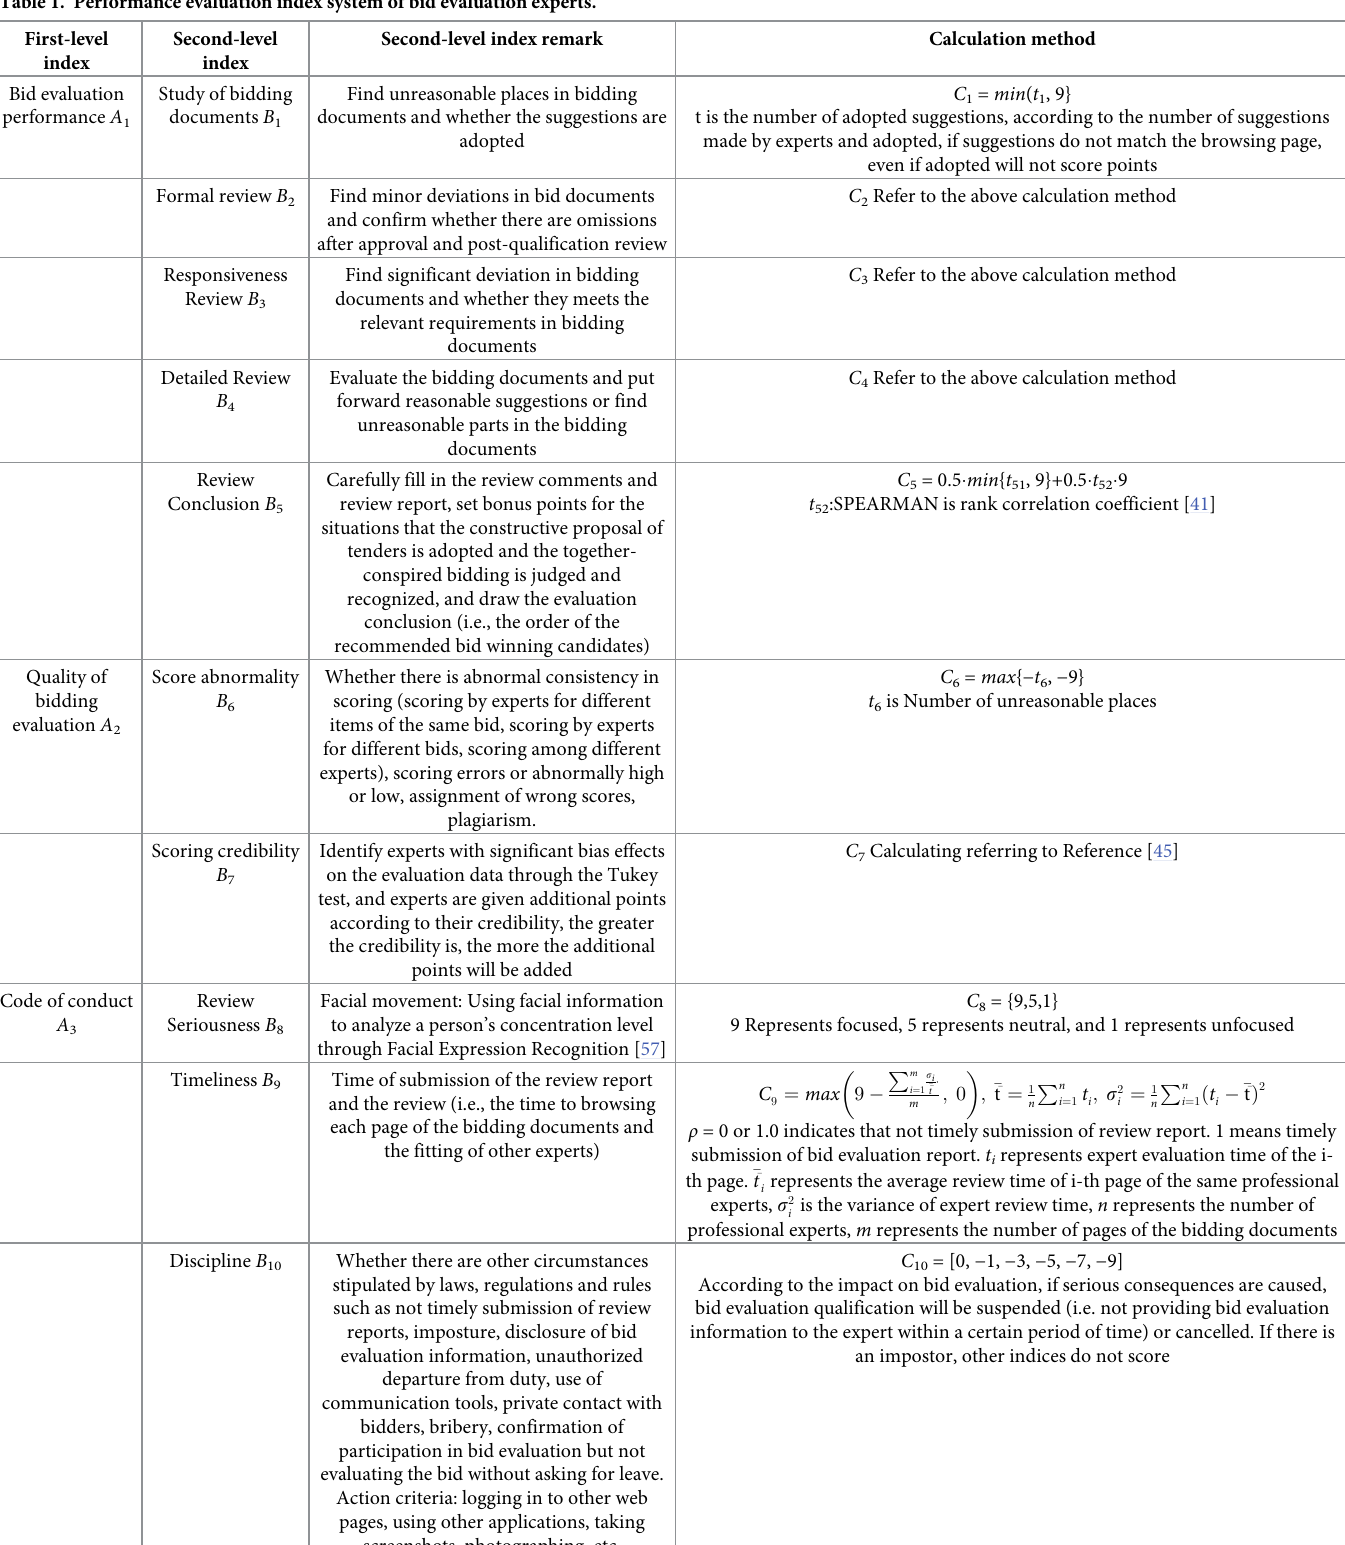
Table 1. Performance evaluation index system of bid evaluation